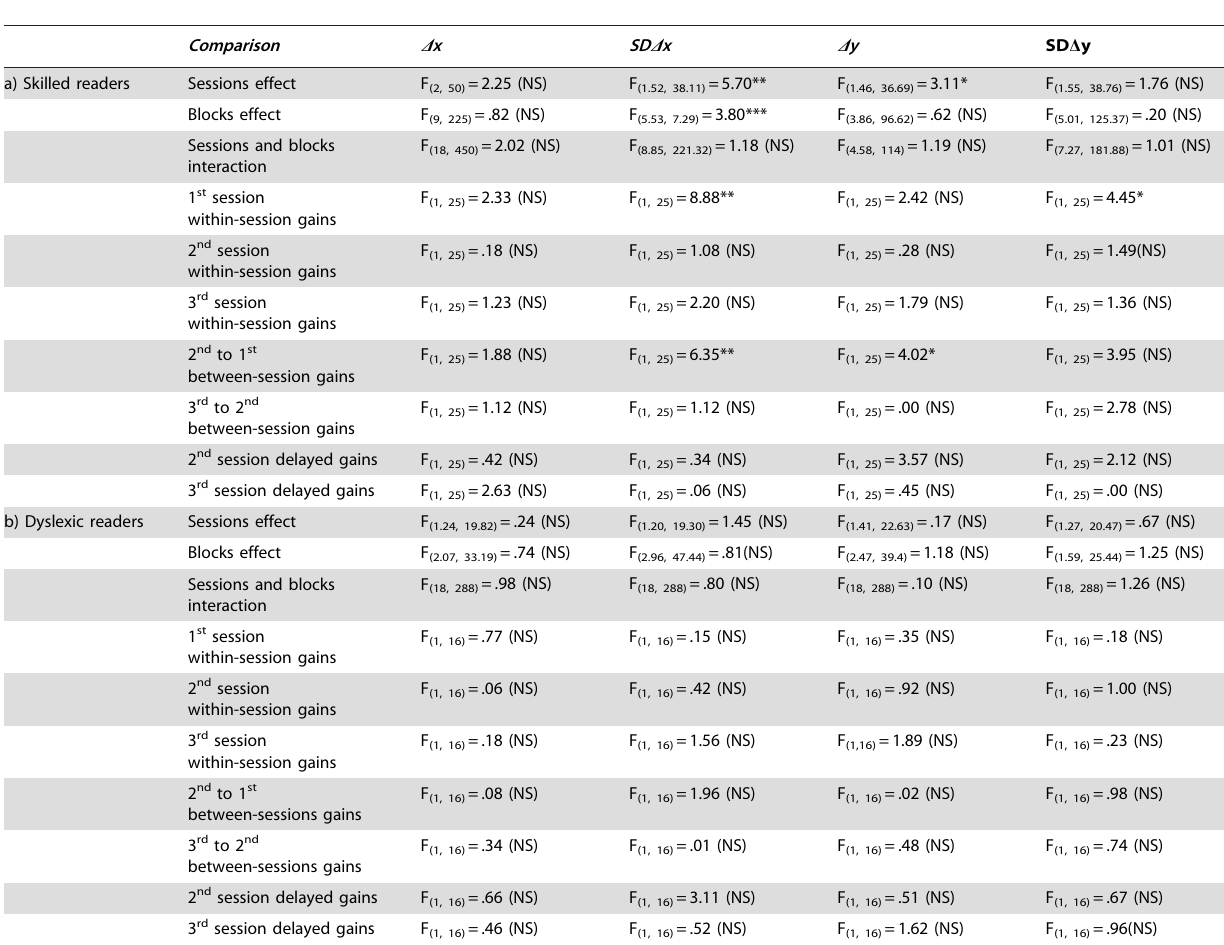
Table 3. ANOVA results for the posture maintenance parameters for a) the skilled readers and b) the dyslexic readers.